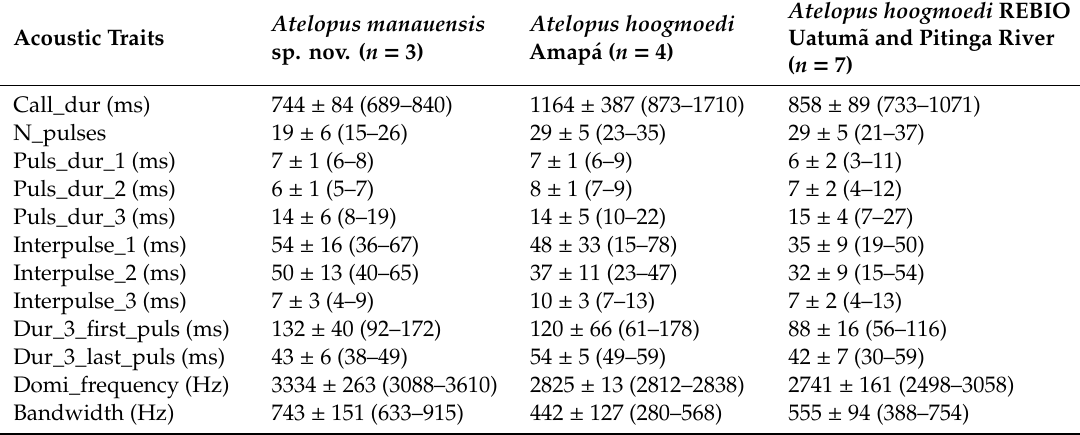
Table 5. Advertisement call parameters for Atelopus manauensis sp. nov., two Brazilian populations of A . hoogmoedi of the Guiana Shield that are the geographically closest to the area of occurrence